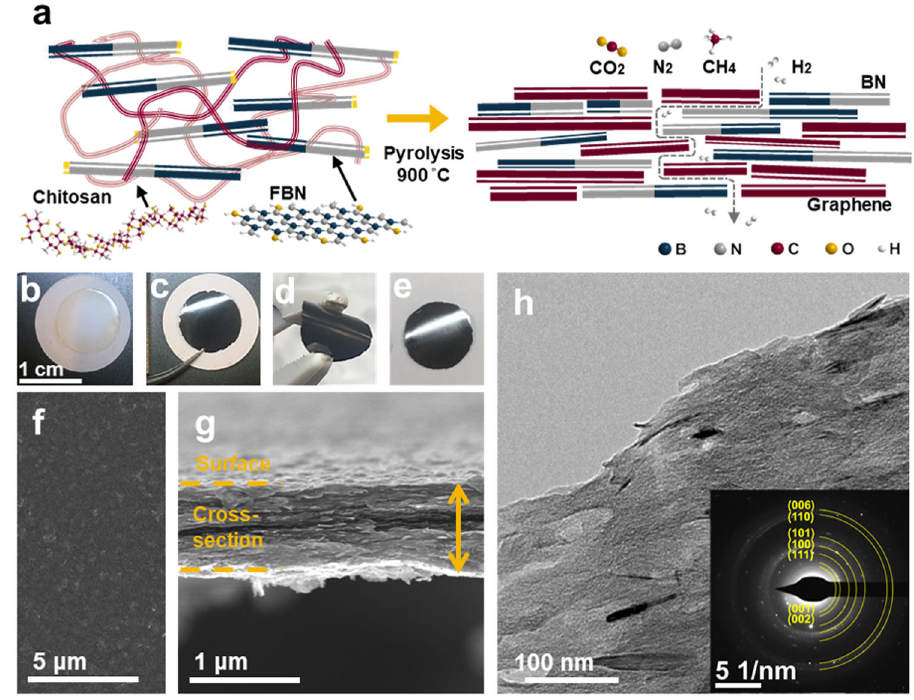
Fig. 1 | Preparation, morphology and structure of boron nitride and graphene nanosheet (BNG) heterostructured membrane. a Schematic illustration depict- ing the pyro-layering approach and gas molecule transport through the BNG membrane. b , c Digital images of the prepared FBN-chitosanprecursor membrane and BNG membrane before and after high-temperature pyro-layering. d , e Digital images of a free-standing BNG membrane bent by tweezers and placed on the